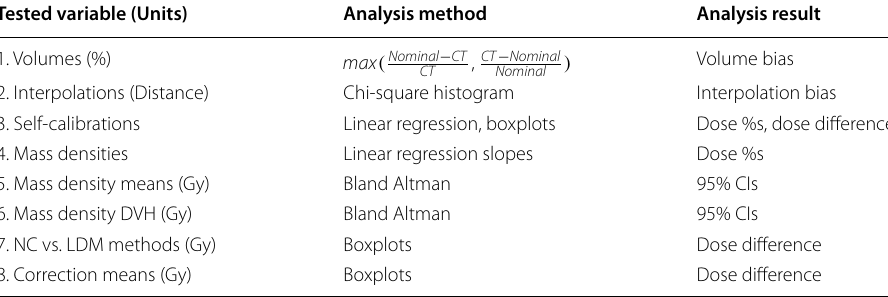
LDM local deposition method